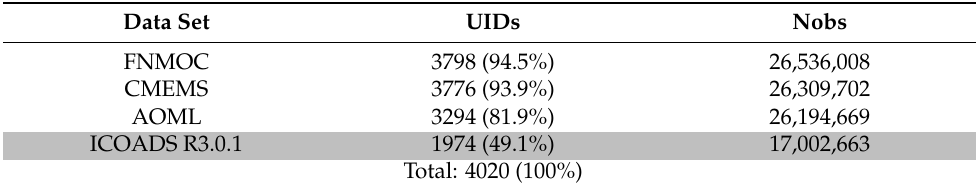
Table 2. The number of unique IDs (UIDs) and observations (Nobs) in four data sets. The total is a logical sum of all UIDs observed in the top three sources (excluding ICOADS) and set as 100%. The ICOADS row is shaded to indicate that these data are discarded from the following analyses. Data Set